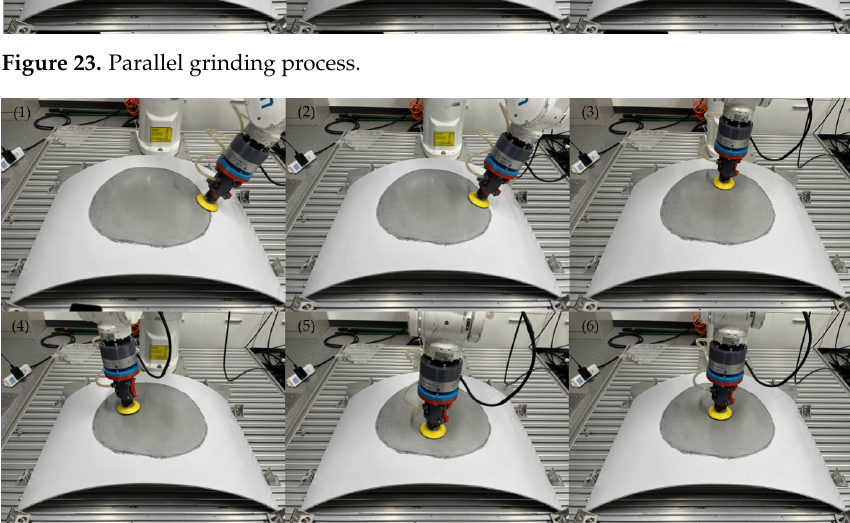
Figure 24. Spiral grinding